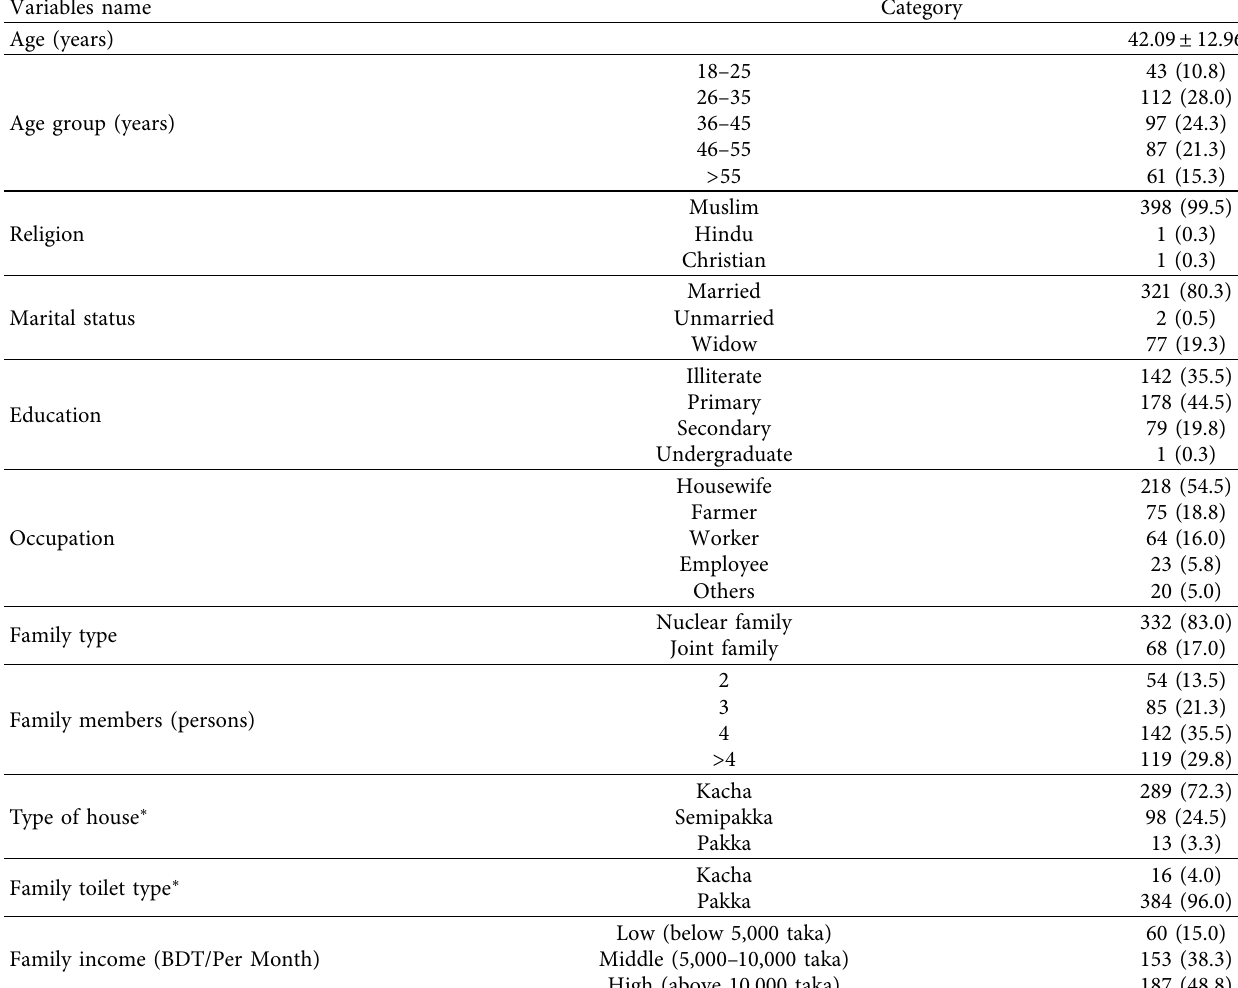
Table 1: Sociodemographic characteristics of the study